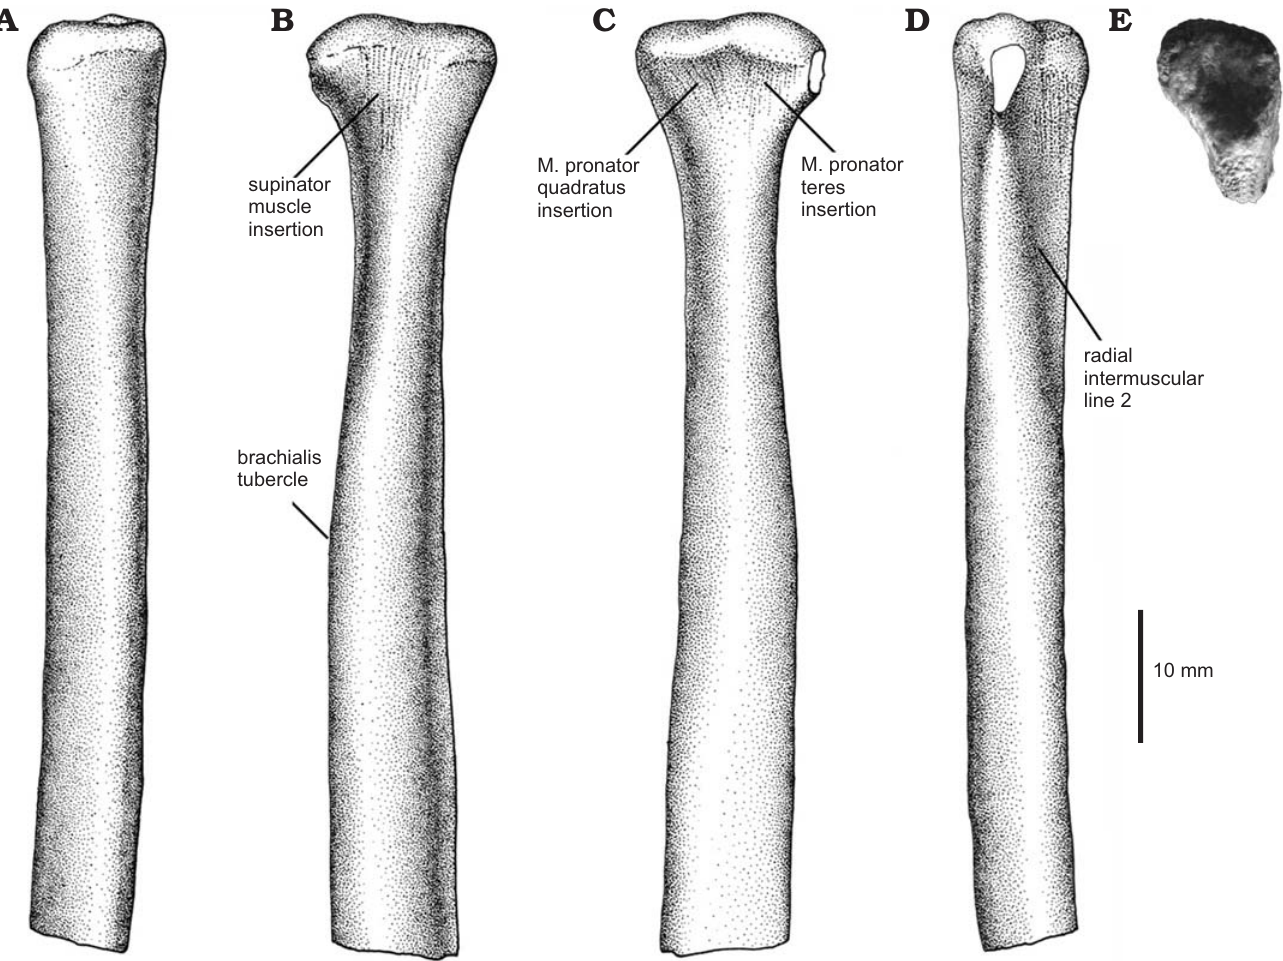
Fig. 3. Unenlagiid theropod Neuquenraptor argentinus Novas and Pol, 2005 (MCF PVPH 77) from Sierra del Portezuelo, Neuquén Province, Argentina; Portezuelo Formation, Coniacian, Late Cretaceous; partial left radius in cranial ( A ), lateral ( B ), medial ( C ), caudal ( D ), and proximal ( E ) views. A–D, drawings; E,